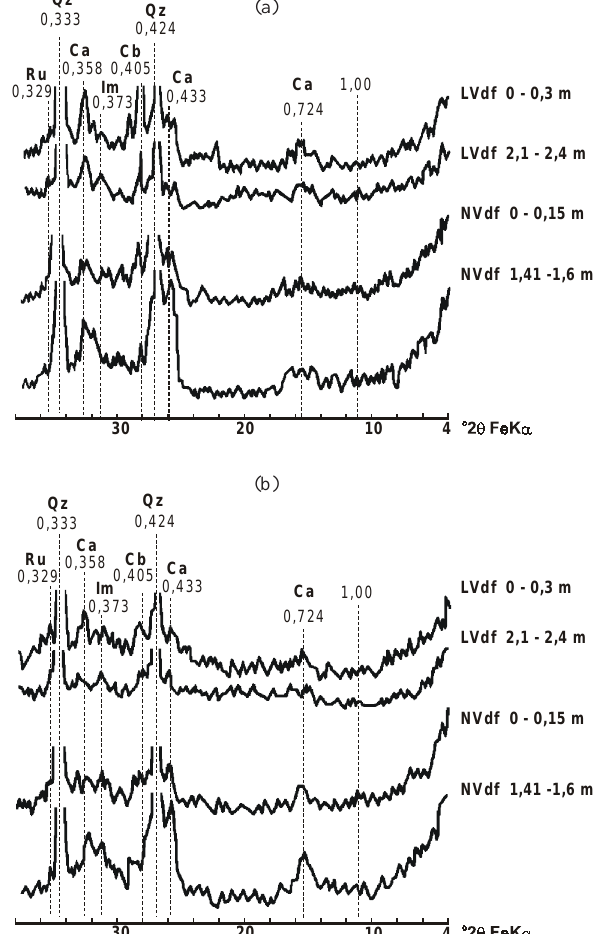
Figura 2. Difratogramas de raios-X da fração silte fino (a) e silte grosso (b) (espaçamento “d” em nm), em duas profundidades, do Latossolo Vermelho distroférrico típico (LVdf) e do Nitossolo Vermelho distroférrico típico (NVdf). Qz = quartzo, Ca = caulinita, Cb = cristobalita, Im = ilmenita, Ru =